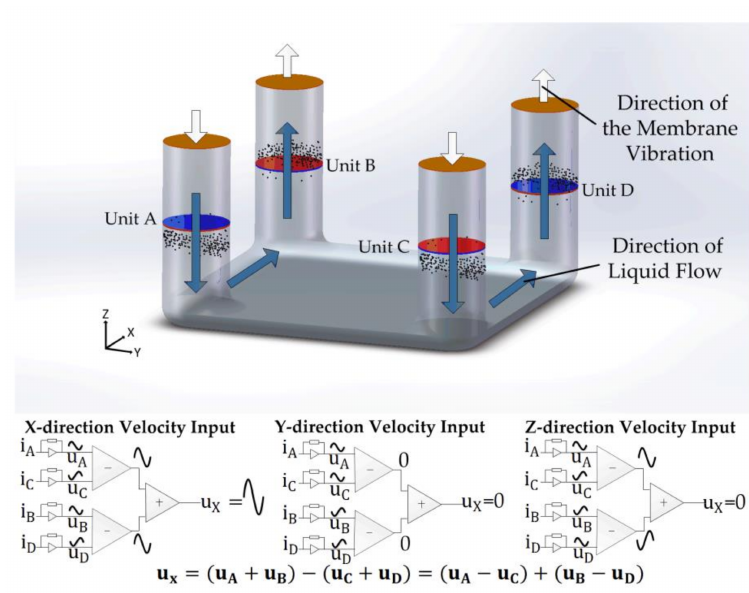
Figure 2. Sensing mechanism illustrations and schematics of fluid flowing mechanism in response to acceleration along x -axis. Blue arrows represent the direction of liquid flow due to the convection caused by the external vibration while white arrows represent the direction of the membrane